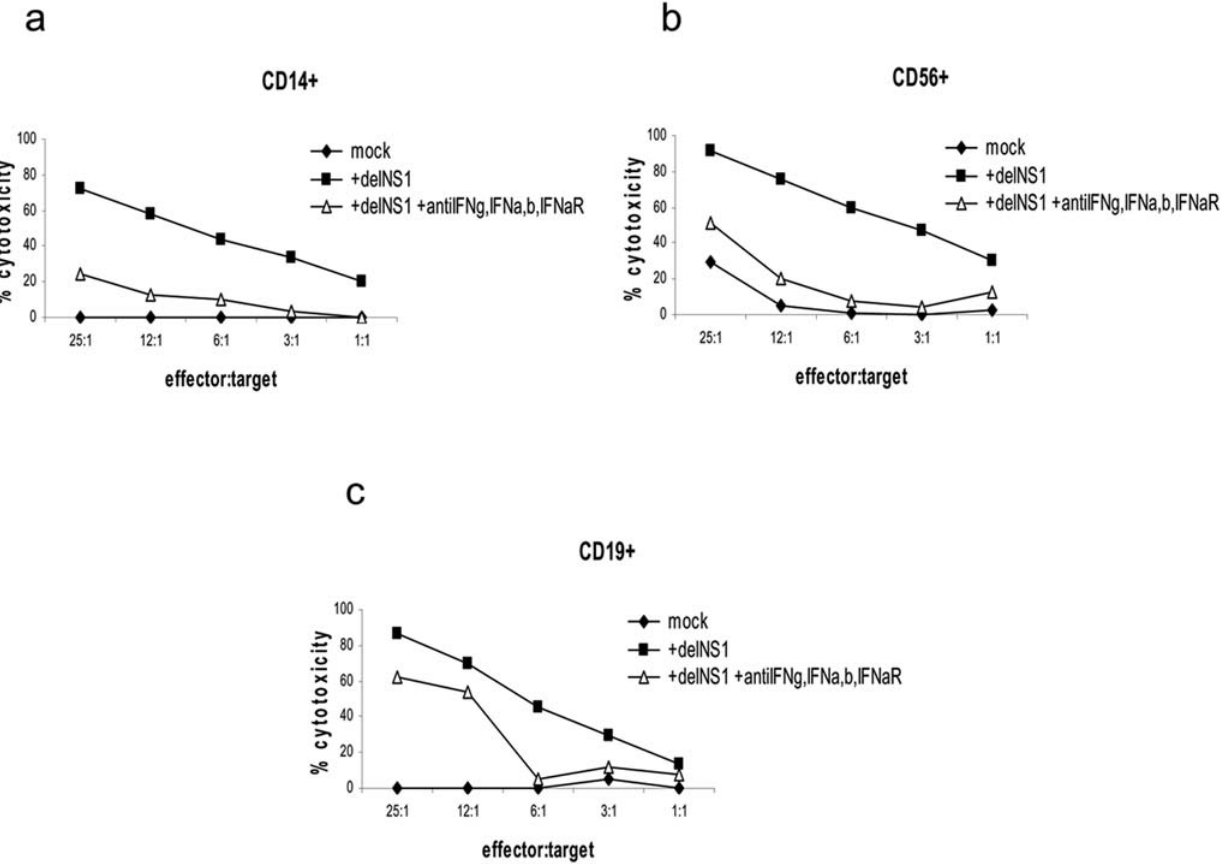
Figure 8. Role of interferon in the anti-tumor cytotoxic immune response by infected monocultures. CD14 + (a), CD56 + (b) and CD19 + cells (c) were infected with delNS1 virus (m.o.i.=0.02) and cultured for 24 hours with or without anti-IFN a , anti-IFN b , anti-IFN c and anti-IFN a -receptor antibodies. Then cells were co-cultured with the target A375 cells for 24 hours and cytotoxicity was assessed. One representative result in percentage of cytotoxicity is given for two experiments which were performed with cells derived from different donors. doi:10.1371/journal.pone.0004122.g008 PLoS ONE |